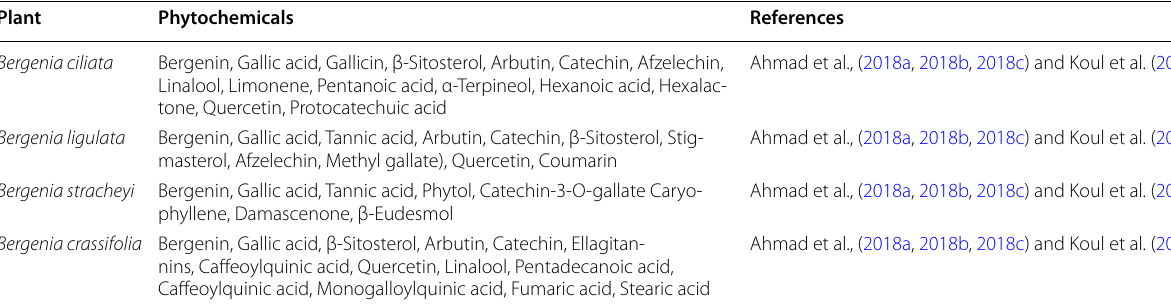
Table 1 Phytochemical constituents of Bergenia species